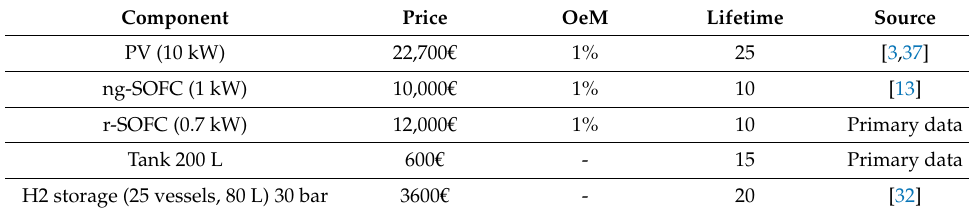
Table 3. Components costs including lifetime and